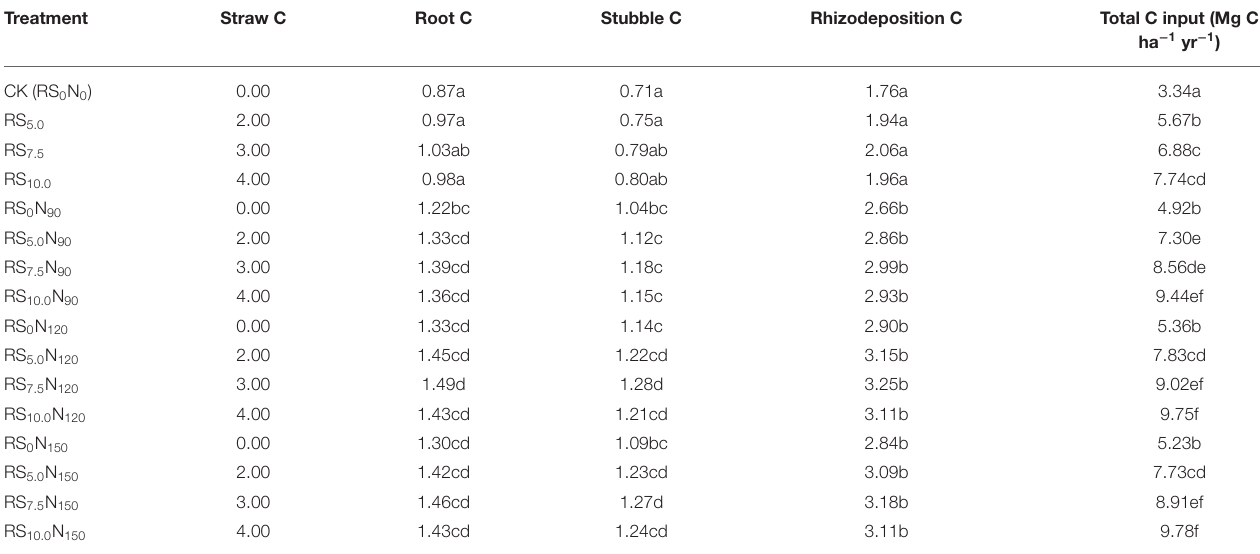
TABLE 3 | Mean annual carbon input (Mg C ha − 1 ) through roots, stubble and rhizodeposition, and addition of rice straw in soil plow (0–15cm) depth under rice-wheat cropping system in north-western India.